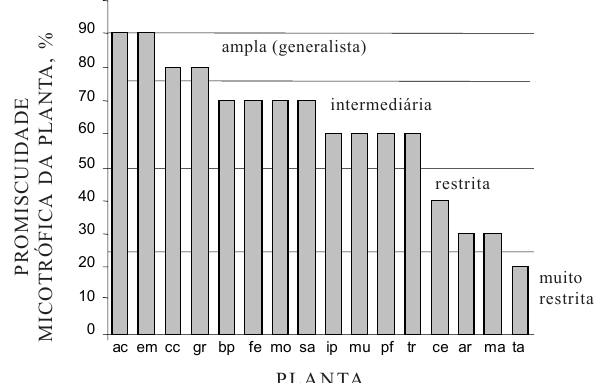
Figura 3. Índice de promiscuidade micotrófica (IPMp) das diferentes espécies vegetais. ac - açoita-cavalo; em - embaúba; cc - cássia-carnaval; gr- gravitinga; bp- bico-de-pato; fe - fedegoso; mo - moreira; sa - sábia; ip - ipê amarelo; mu - mutamba; pf - pau-de-ferro; tr - trema; ce - cedro; ar - aroerinha; ma - maricá; ta -